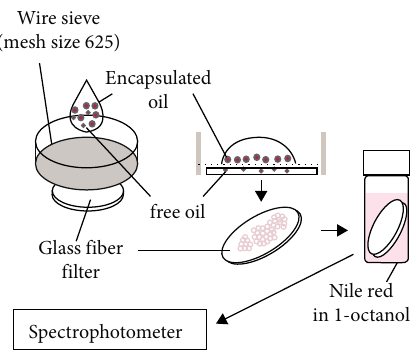
Figure 29: Schematic of the measuring of released bake fl avour oil